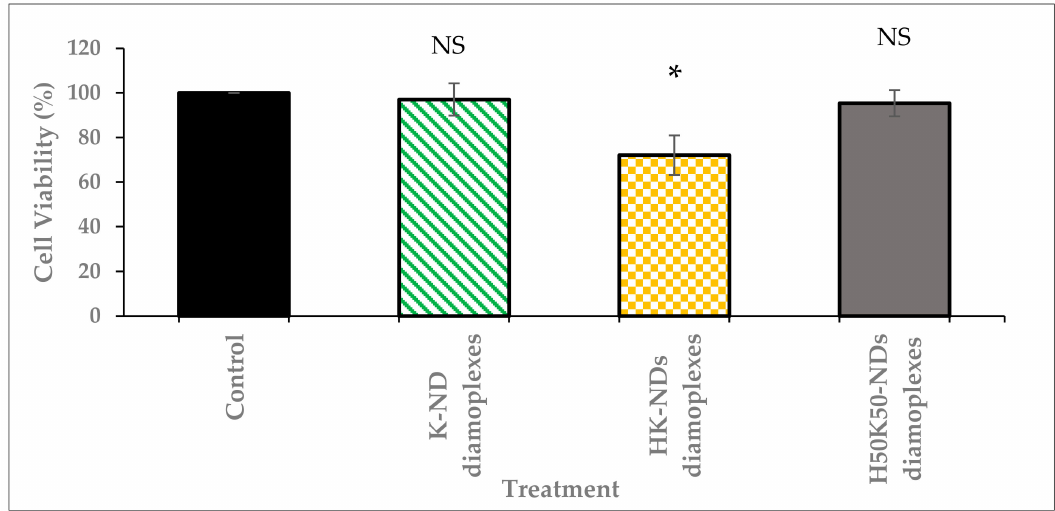
Figure 7. Cell viability after treatment with diamoplexes of K-NDs, HK-NDs and H 50 K 50 -NDs. Diamoplexes impact cell viability in the following order: K-ND ≈ H 50 K 50 -NDs <